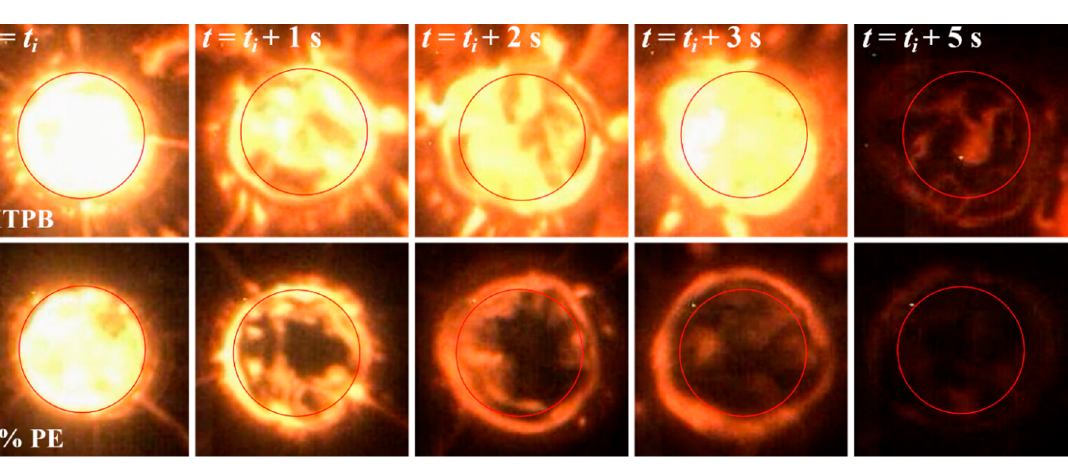
Figure 4. Photograph of regression process of pure HTPB ( top ) and polymer particles / HTPB ( bottom ) fuels. All pictures were obtained at the same exposure and aperture.